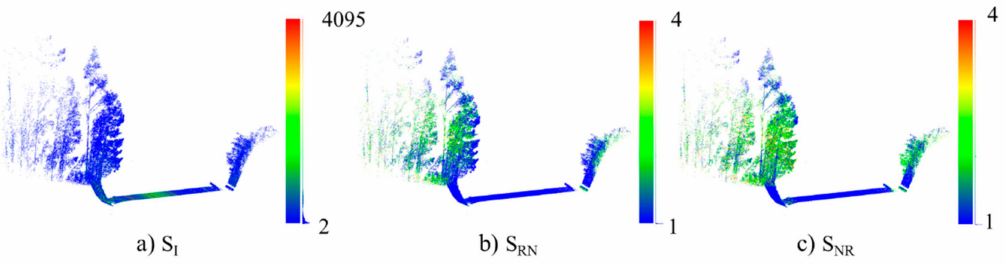
Figure 4. Point cloud colored by: ( a ) intensity S I , ( b ) return number S RN and ( c ) total number of returns S NR